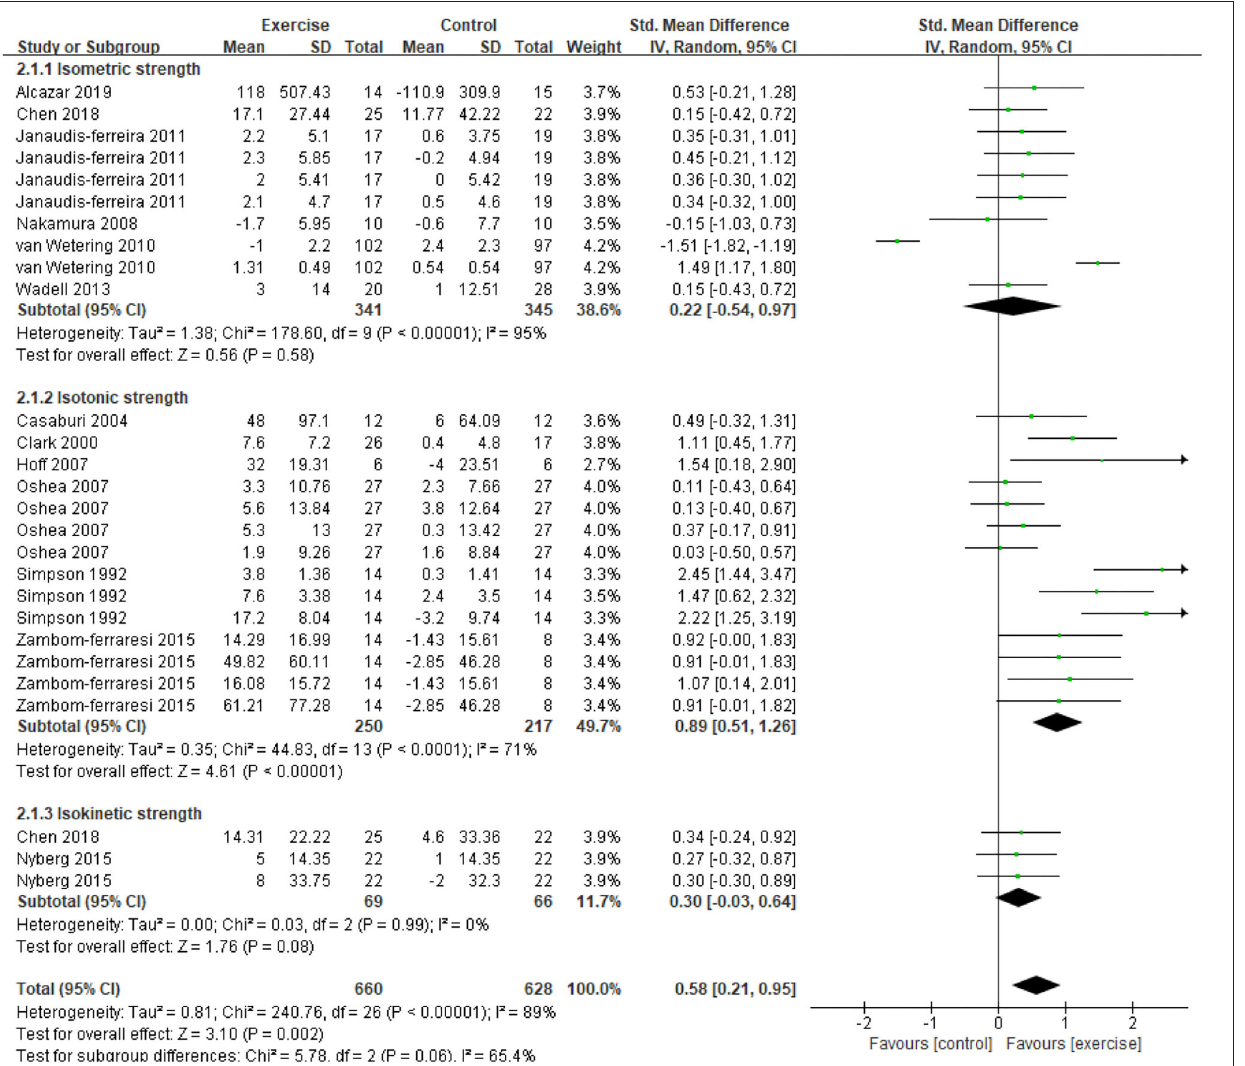
FIGURE 4 | Effects of exercise on skeletal muscle strength evaluated by three types of measurements in patients with COPD. CI, confidence interval; COPD, chronic obstructive pulmonary disease; SD, standard deviation.